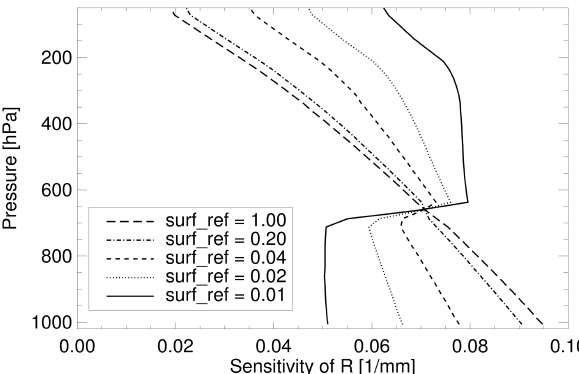
Fig. 4. Sensitivity in 1/mm of the apparent transmittance R to the water vapour column content as a function of pressure (height lev- els) for five different surface reflectances (surf ref). A constant aerosol layer at 700 hPa is present. Table 1. Sensitivity simulations input parameter cases. a function of height for five different surface reflectances. 355 Property The sensitivities for each layer were derived from the dif- ference between the reference ratio and the ratio simulated with an increased water vapour content (+0.1 mm) in that layer divided by the change in water vapour. For reference the US standard water vapour profile was chosen and a ho- 360 mogeneous continental aerosol layer at 700 hPa (3000 ± 250 m) with an optical thickness at 900 nm of 0.1. As the fig- ure clearly shows, the peak altitude of the sensitivity is gov- erned by the surface reflectance and the aerosol layer height.